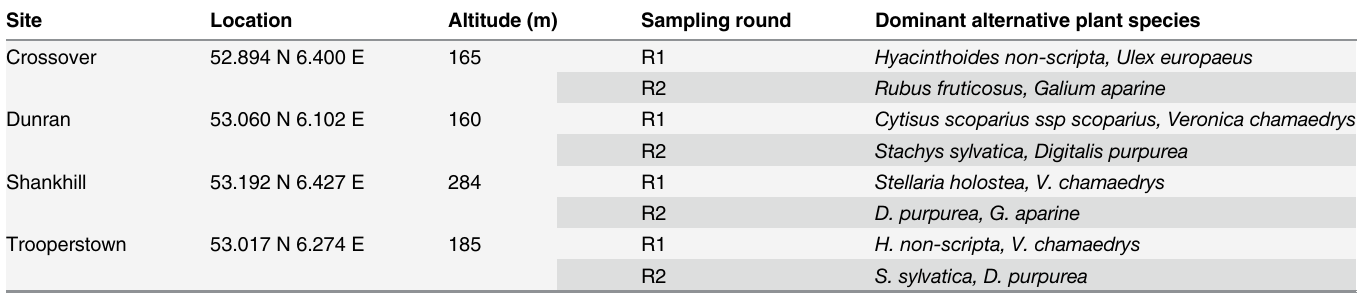
Table 1. Study site